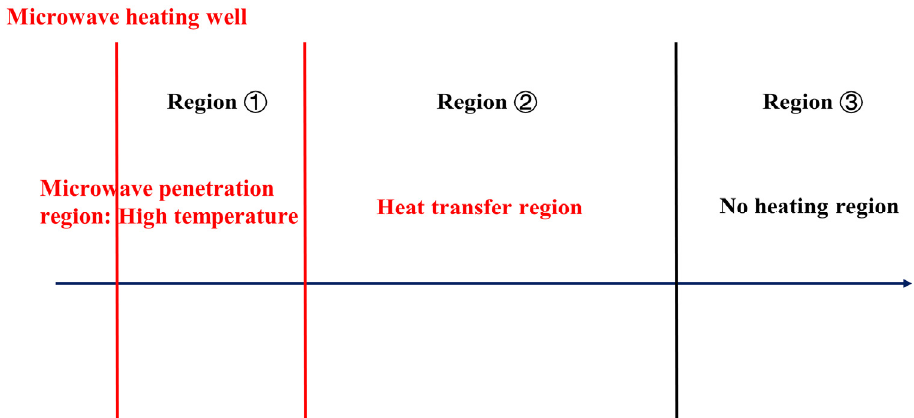
Figure 6. Heating mechanism of oil shale layer subjected to microwave heating.